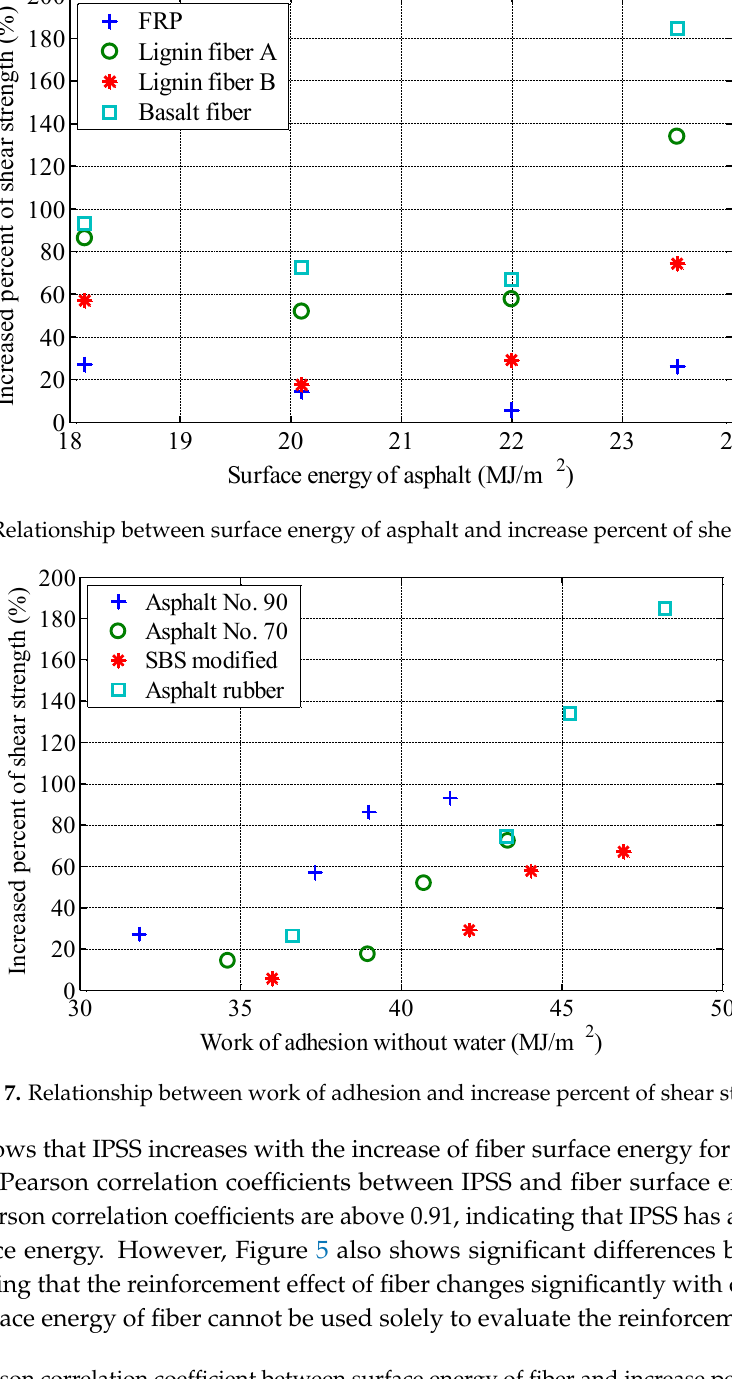
Table 8. Pearson correlation coefficient between surface energy of fiber and increase percent of shear strength (IPSS).